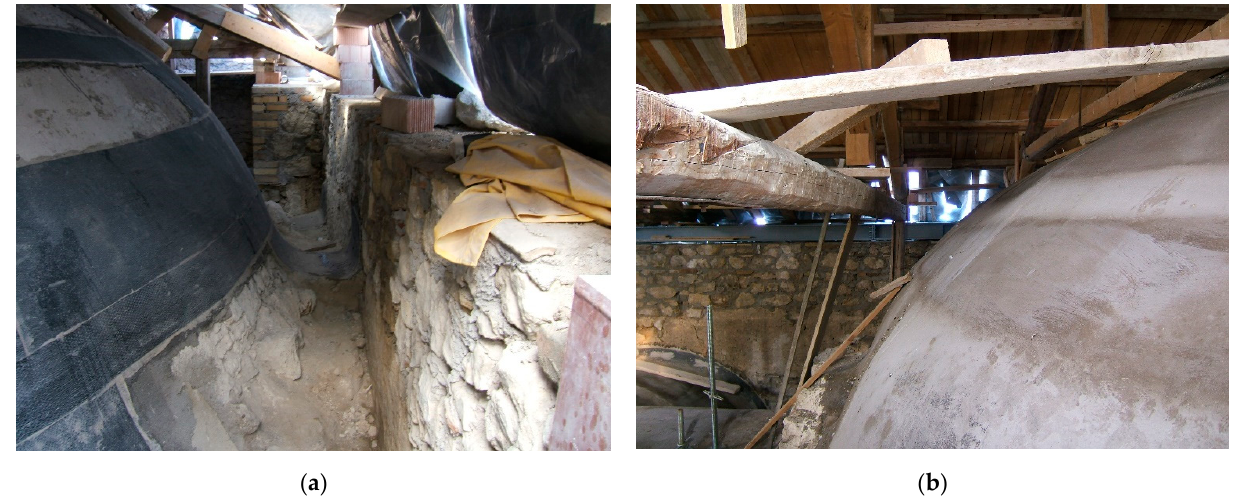
Figure 4. Composite strengthening of a dome vault: ( a ) detail of the composite reinforcement; ( b ) detail of the completed intervention.